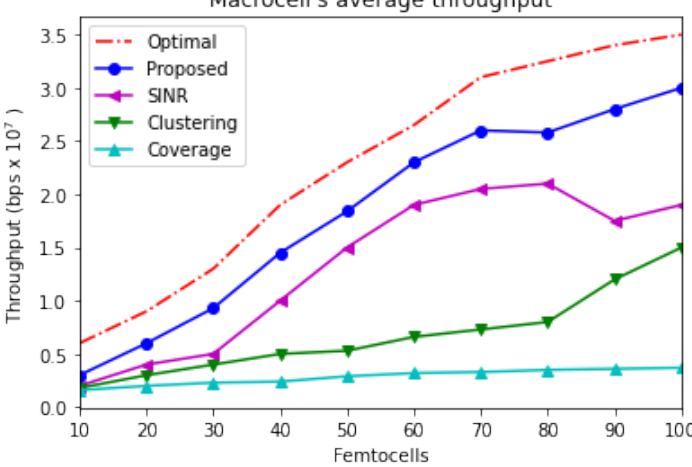
Figure 4. Macrocell average